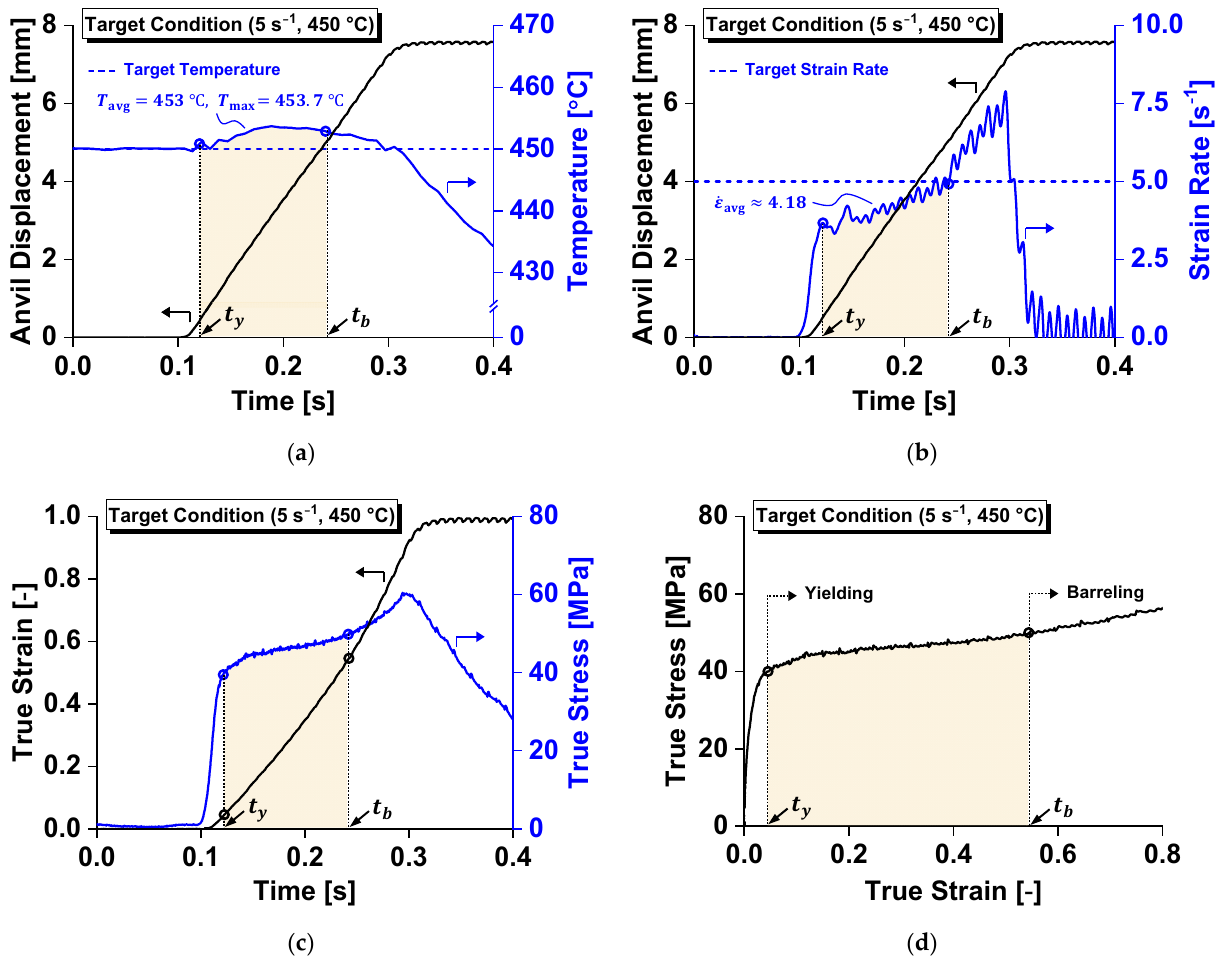
Figure 2. Variations in the physical quantities during compression under the target test conditions of a strain rate of 5 s − 1 and a temperature of 450 °C: ( a ) temperature; ( b ) strain rate; ( c ) in situ stress and strain responses; and ( d ) flow stress curve.